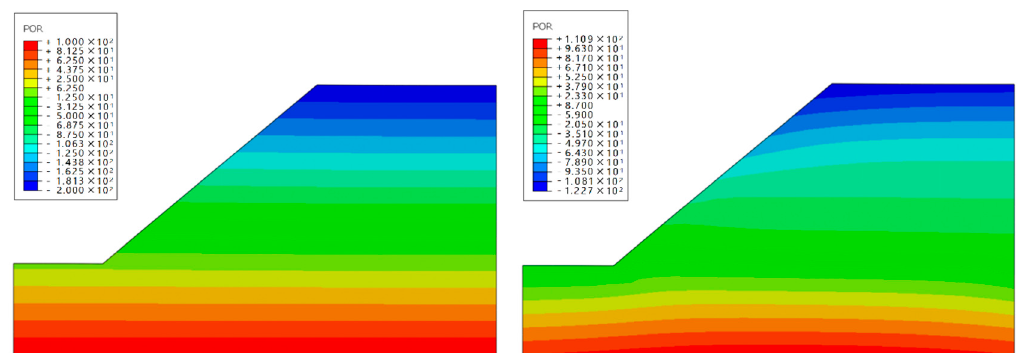
Figure 7. Pore water pressure distribution of the slope before and after rainfall.